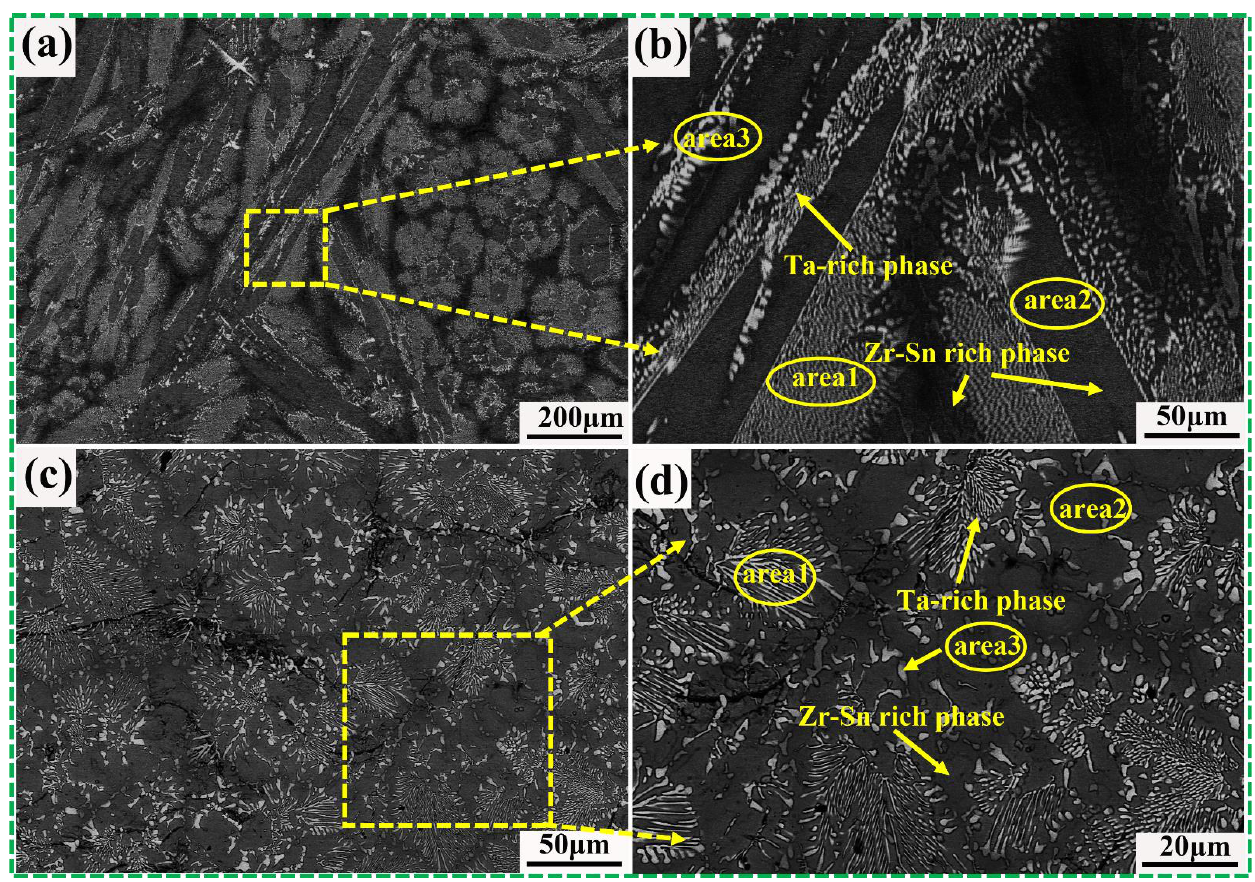
Figure 2. The microstructure of Sn30 BHEA and Sn35 BHEA. ( a , b ) Sn30 BHEA, ( c , d ) Sn35BHEA. Table 2. EDS analysis of the phase in Figure 2. Table 2. EDS analysis of the phase in Figure